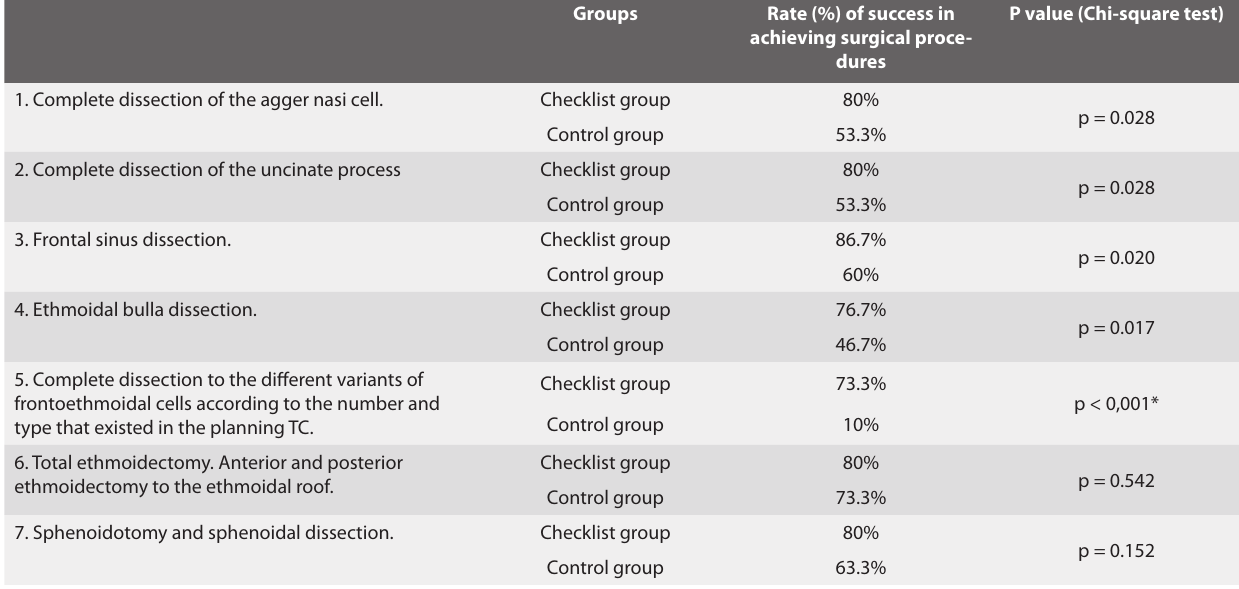
Table 3. Rate (%) of success in achieving surgical procedures, and Chi-square test values..